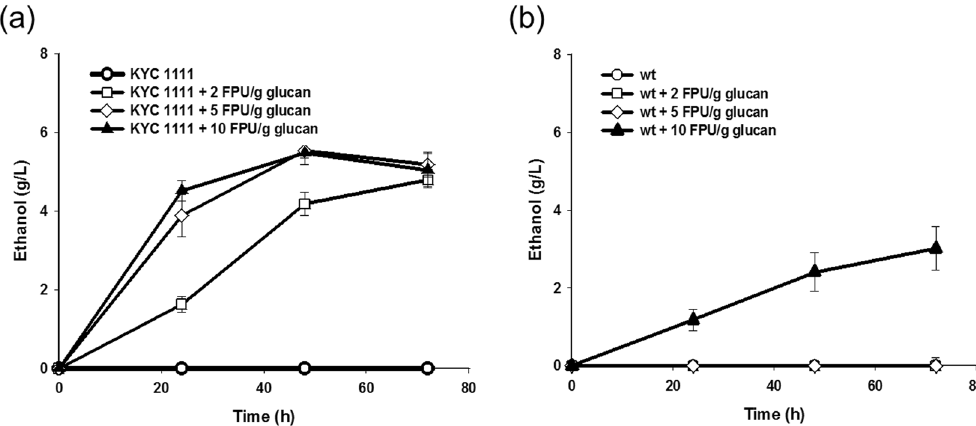
Figure 6. Ethanol production by the KYC 1111 mixture. The recombinant mixture KYC1111 was fermented using 2% MI-Avicel with several concentrations of Celluclast 1.5 L (0, 2, 5, and 10 FPU/g glucan). The graphs show the time course release of ethanol produced by the KYC1111 ( a ) and wild-type cells with empty vector ( b ) with no enzyme (circles), 2 FPU/g glucan (squares), 5 FPU/g glucan (diamonds), and 10 FPU/g glucan (triangles). Experiments were performed in triplicate and repeated three